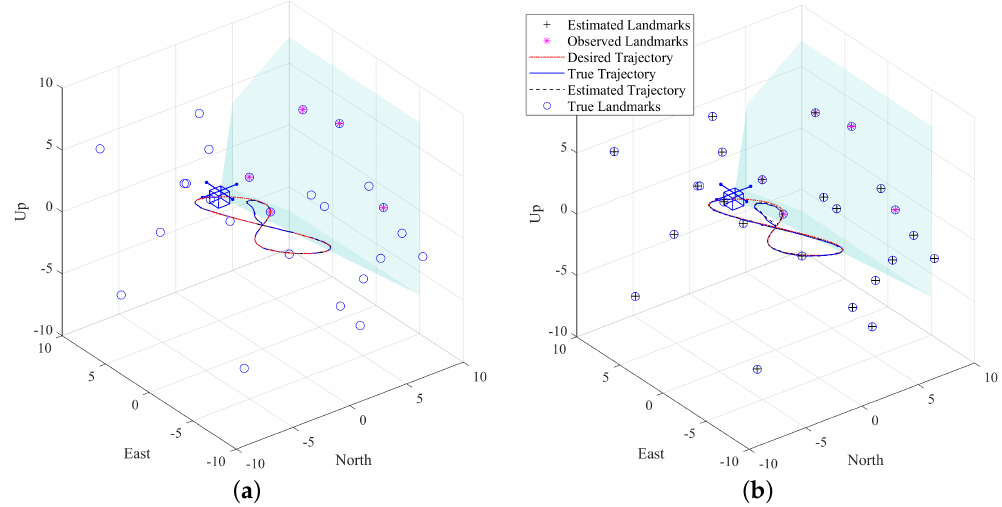
Figure 7. Quadcopter traversing 8-shape trajectory for different scenarios. ( a ) Known landmarks. ( b ) Unknown